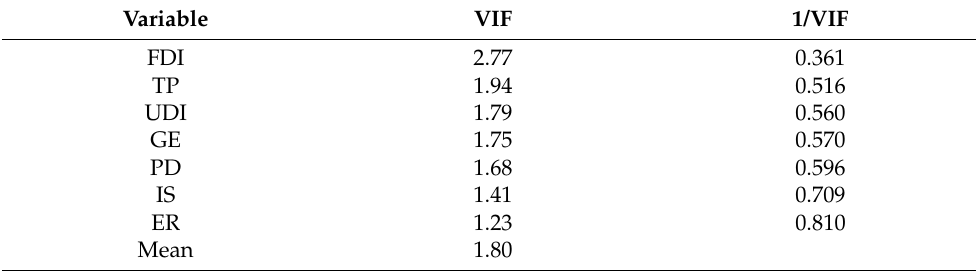
Table 5. Variance inflation factor independence